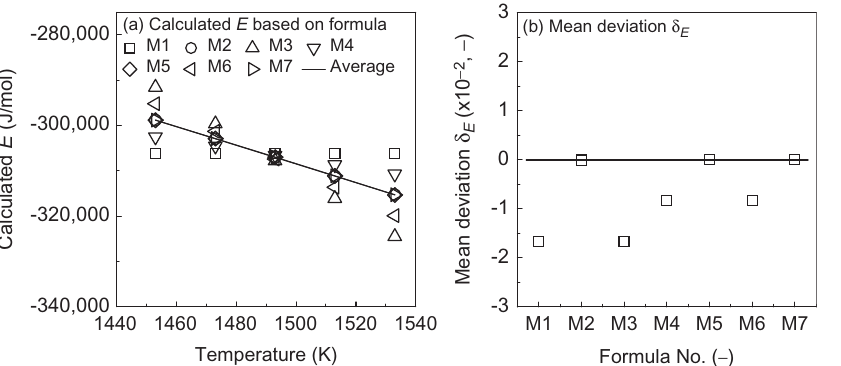
Figure 7: Comparison of calculated apparent activation energy E (a) and mean deviation δ E (b) by seven collected formulas of k over a temperature range from 1453 to 1533 K, respectively.